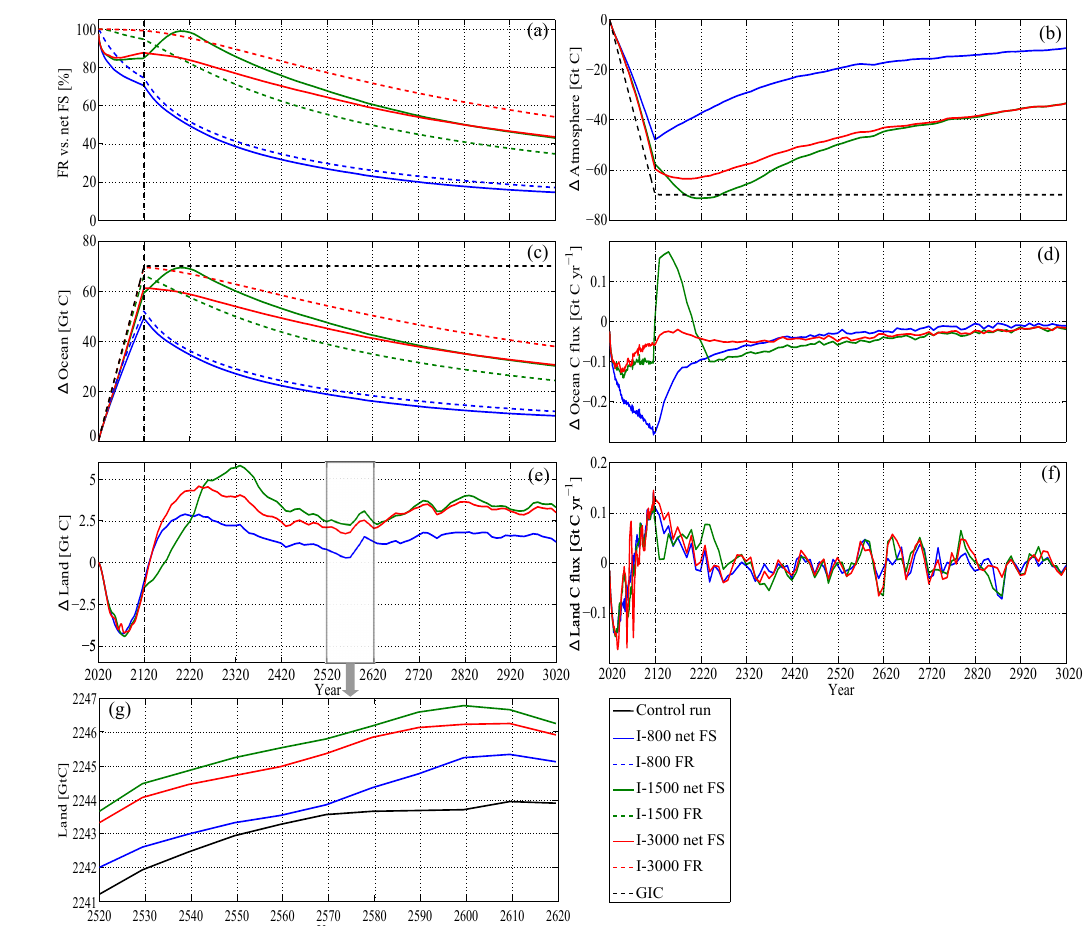
Figure 4. (a) Comparison of the fractions retained (FR, dashed) and the net fractions stored (netFS, solid) of the With Emissions (WE) simulations. Absolute changes in carbon between the WE simulations and the RCP 8.5 control run (WE simulations minus RCP 8.5 control run) for (b) globally integrated total atmospheric carbon, (c) globally integrated total oceanic carbon, (d) globally integrated carbon flux from atmosphere to ocean, (e) globally integrated total land carbon, (f) globally integrated carbon flux from atmosphere to land, and (g) absolute values of globally integrated total land carbon of the WE simulations and the RCP 8.5 control run from the year 2520 to 2620. The globally injected carbon is denoted as GIC. The vertical dashed black lines indicate the end of the injection